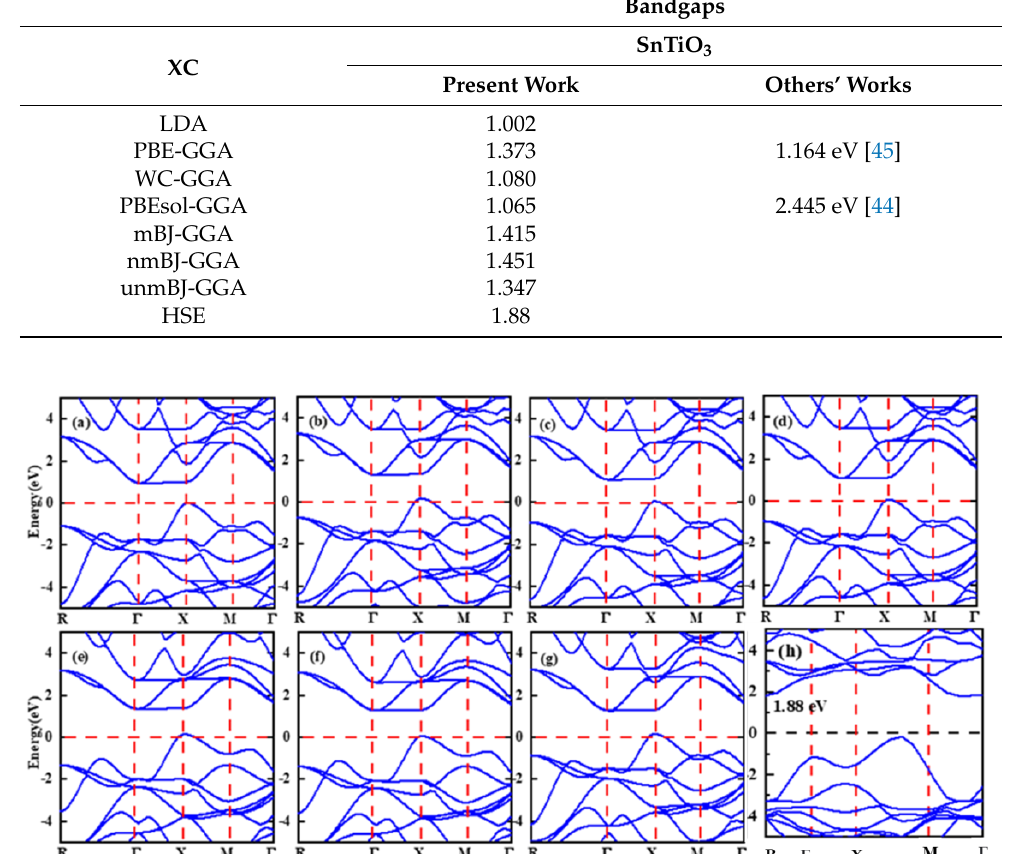
Figure 3. SnTiO 3 of band structures at their equilibrium lattice constants estimated using ( a ) LDA, ( b ) PBE-GGA, ( c ) WC-GGA, ( d ) PBEsol-GGA, ( e ) mBJ, ( f ) nmBJ, ( g ) unmBJ, and ( h ) HSE approxi- mation.